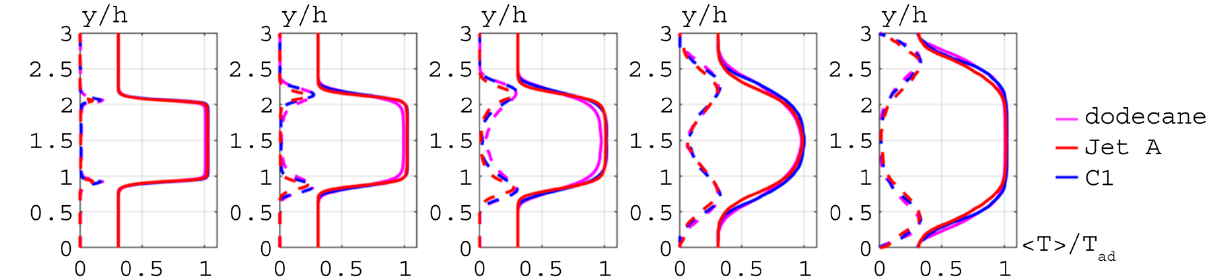
Figure 7. Comparison of time-averaged temperature, (cid:104) (cid:101) T (cid:105) , and rms temperature fluctuations, T rms , at x / h = 0.375, 0.95, 1.53, 3.75, and 9.40, from left to right, between the LES-LDKM-EDC simulations of n-dodecane, Jet A, and C1 at φ = 0.66.